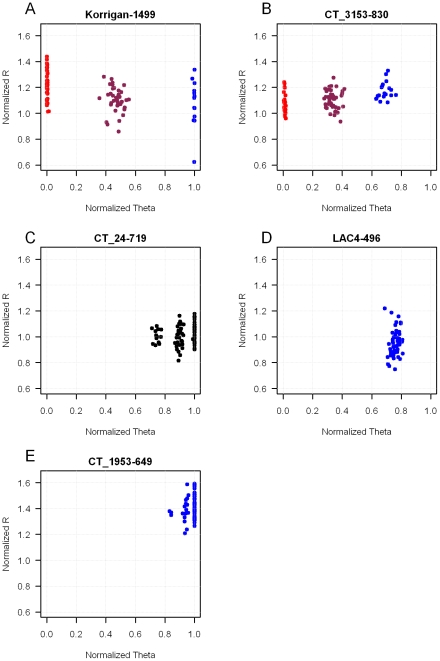
Examples of clustering observed for the P. pinaster SNP array.Each dot represents the mean intensity derived from a population of beads for a single sample. The normalized R (y axis) is the normalized sum of intensities of the two dyes (Cy3 and Cy5), and the normalized Theta (x axis) is ((2/Л)Tan−1 (Cy5/Cy3)), where a normalized Theta value nearest 0 is a homozygous for allele A and a Theta value nearest 1 is homozygous for allele B. A/ classical pattern with three clusters for a SNP considered as successful and polymorphic. B and C/ “cluster compression” when both homozygous clusters are closer to each other than expected. In panel B, the clustering algorithm is able to distinguish the three clusters and gives a GenTrain score of 0.58, however this kind of pattern was considered as a genotyping failure in our analysis because one of the homozygous cluster normalized Theta value does not fall in the [0, 0.1] or [0.9, 1] ranges. In panel C the clustering algorithm was not able to distinguish the three clusters because of low separation scores, and the SNP was automatically considered as a genotyping failure because of its low GenTrain score. D and E/ SNPs interpreted as genotyping failures either because of abnormal Theta values (D) or because of the presence of subgroups in a cluster (E).